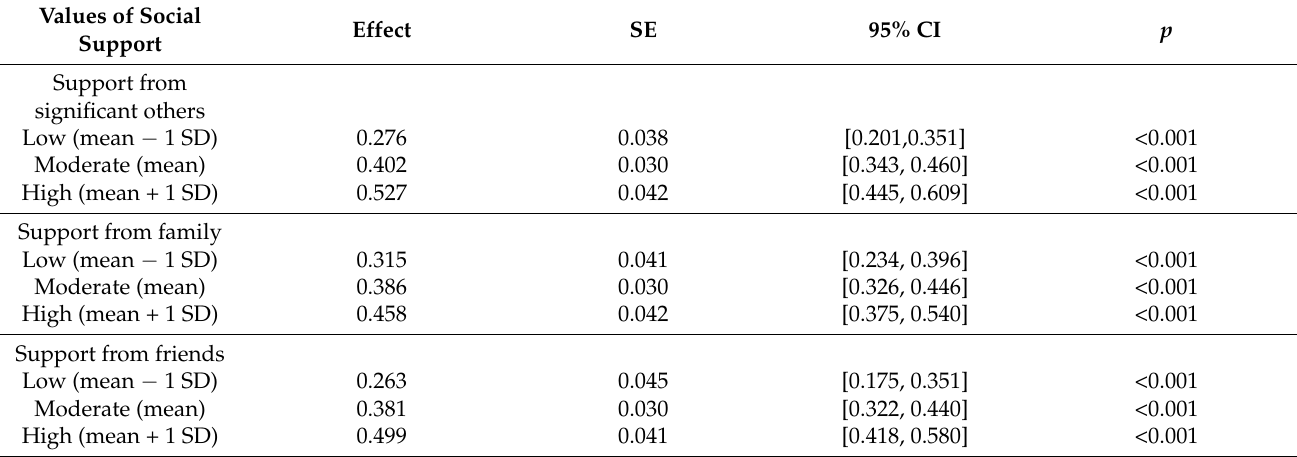
Table 5. Conditional effects of perceived stress on anxiety at the − 1 SD, mean, and + 1 SD level of social support.